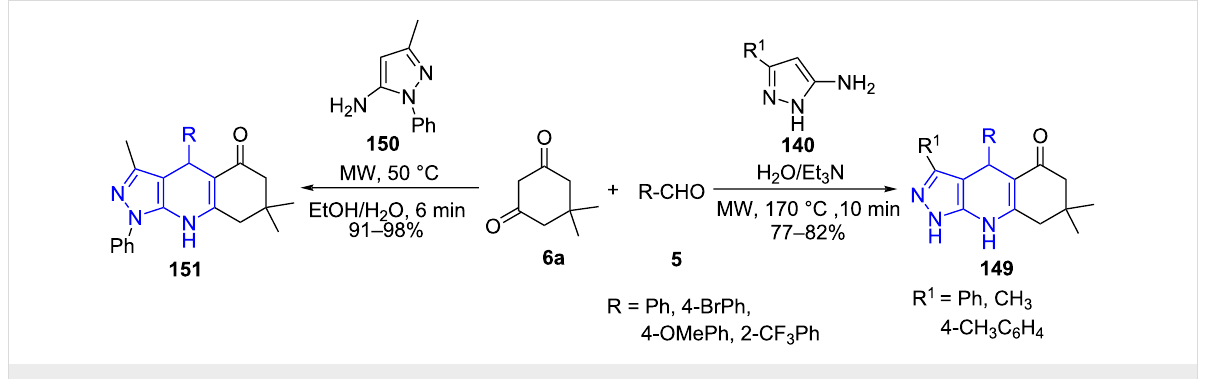
Scheme 62: Synthesis of pyrazoloquinoline.